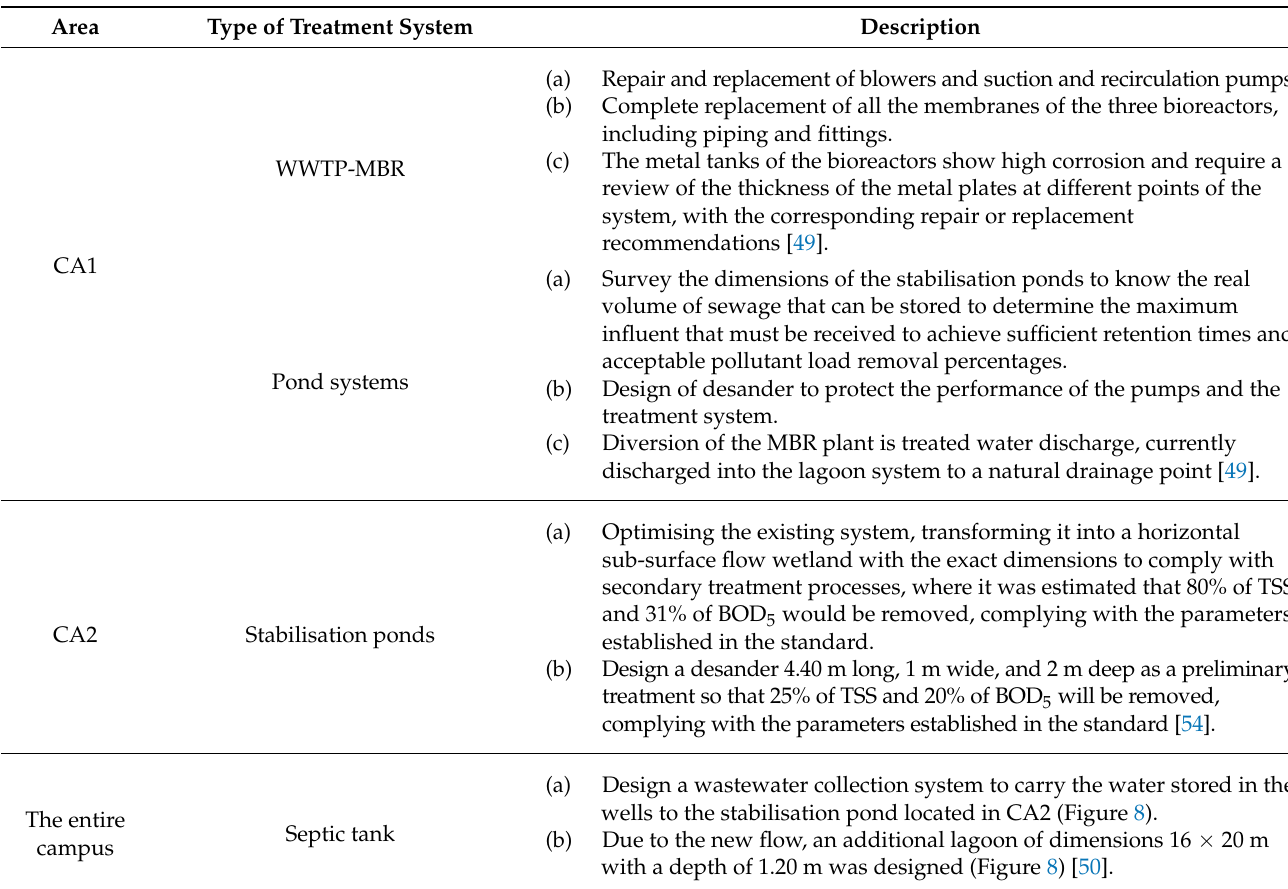
Table 4. Proposals for improvement of existing treatment